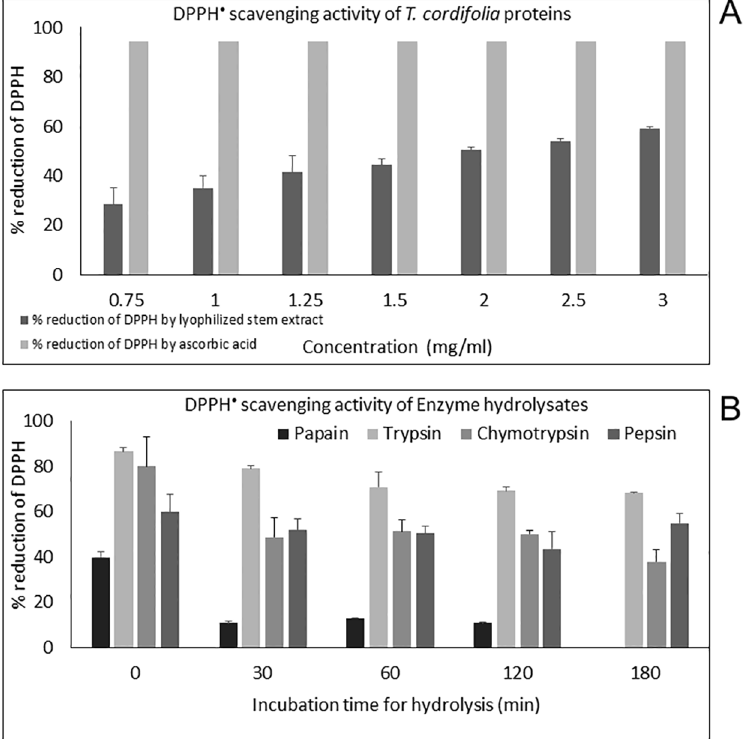
Fig 4. Comparison of percentage reduction of DPPH. (A) by different concentrations of T . cordifolia stem proteins and same concentrations of Ascorbic acid; (B) by T . cordifolia stem proteins hydrolyzed in vitro for various time intervals by different gastrointestinal enzymes (Papain, Trypsin, α -Chymotrypsin, and Pepsin).